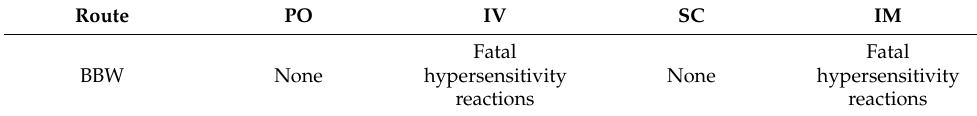
Table 2. Recommendations based on pharmacokinetics of varying vitamin K